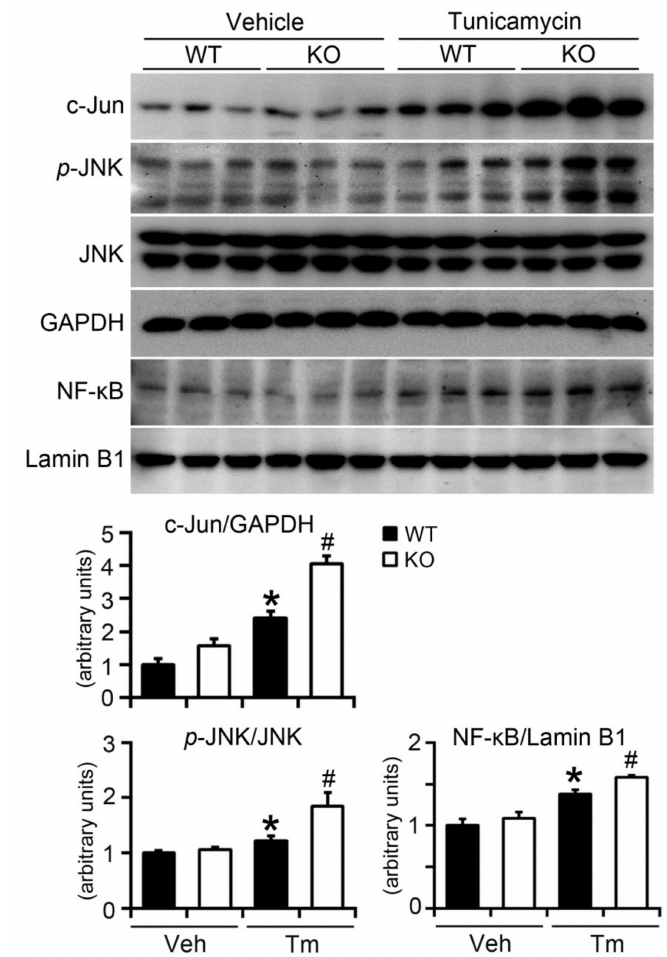
Figure 6. BAP31 deficiency increased inflammatory response in mice upon Tunicamycin injection. Immunoblot analysis of c-Jun, p -JNK, and NF- κ B in mice livers. GAPDH and Lamin B1 were used as a loading control. Data represent as mean ± SEM. *, p < 0.05, KO compared with WT mice injected with Tm. #, p < 0.05, KO compared with WT mice injected with